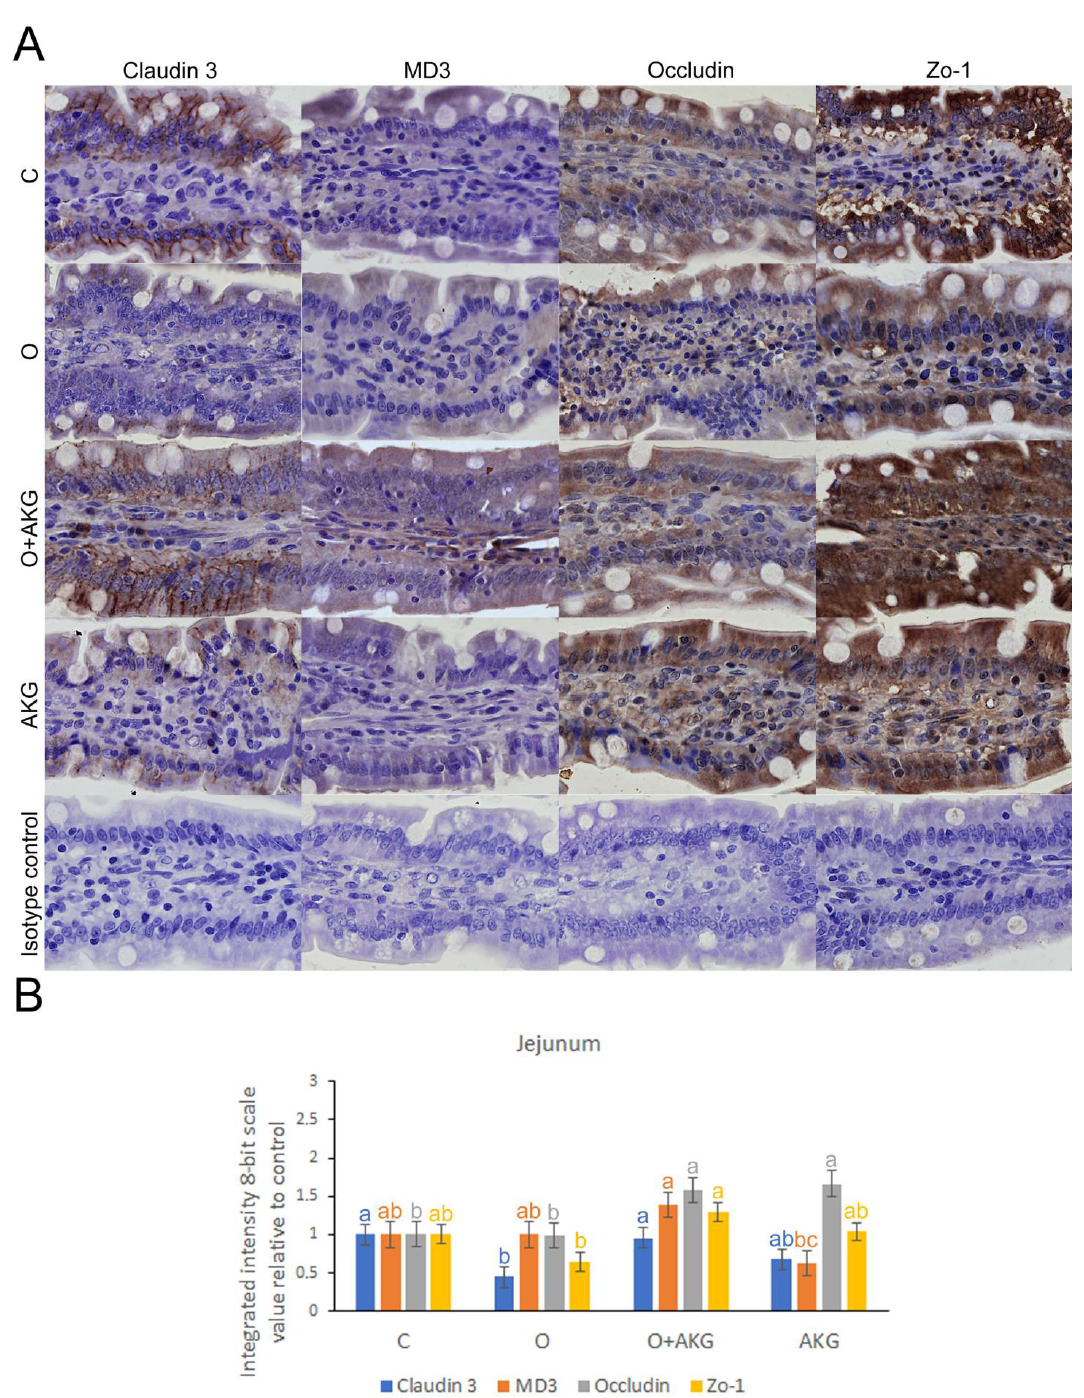
Figure 4. Effects of bariatric surgery and alpha-ketoglutarate (AKG) administration on selected tight junction proteins of the intestinal barrier. ( A ) Representative images of the immunolocalization